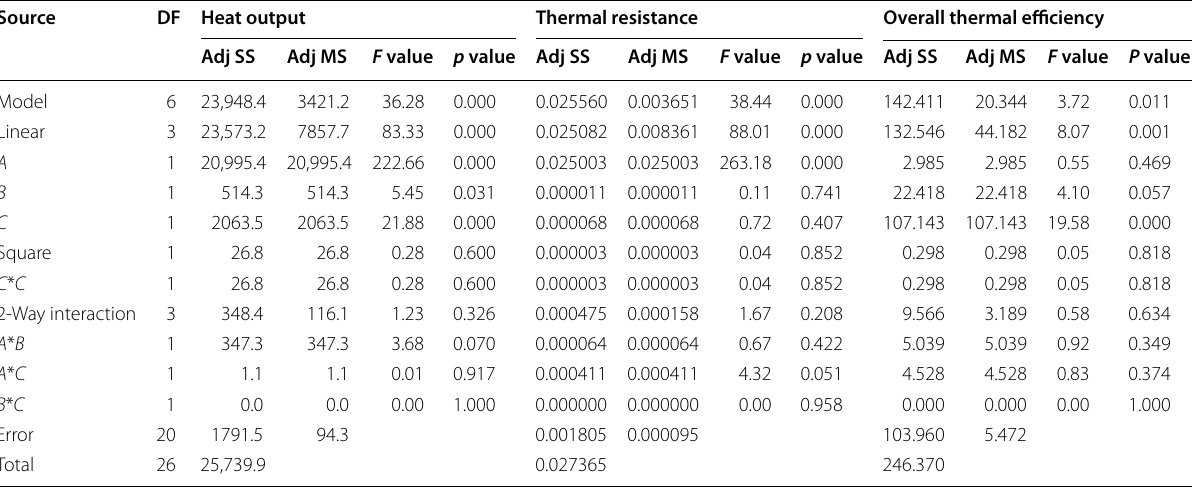
Table 4 ANOVA results of output characteristics of a V-grooved absorber